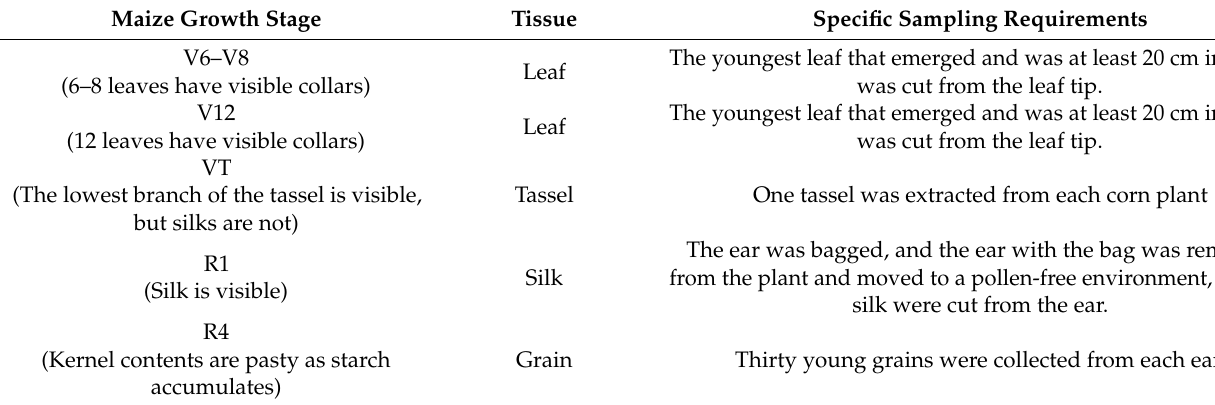
Table 1. Maize at different growth stages and tissue sampling